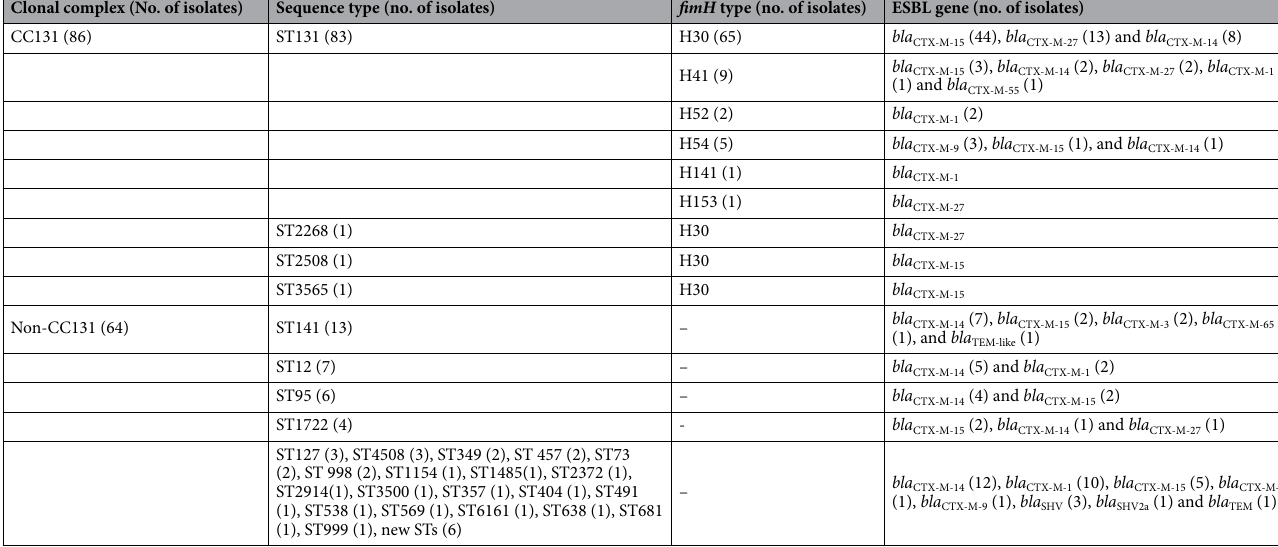
Table 1. Sequence Type distribution for 150 ESBL-producing clinical E. coli belonging to the phylogroup B2 in the University hospital of Besançon (France) between February 2015 and January